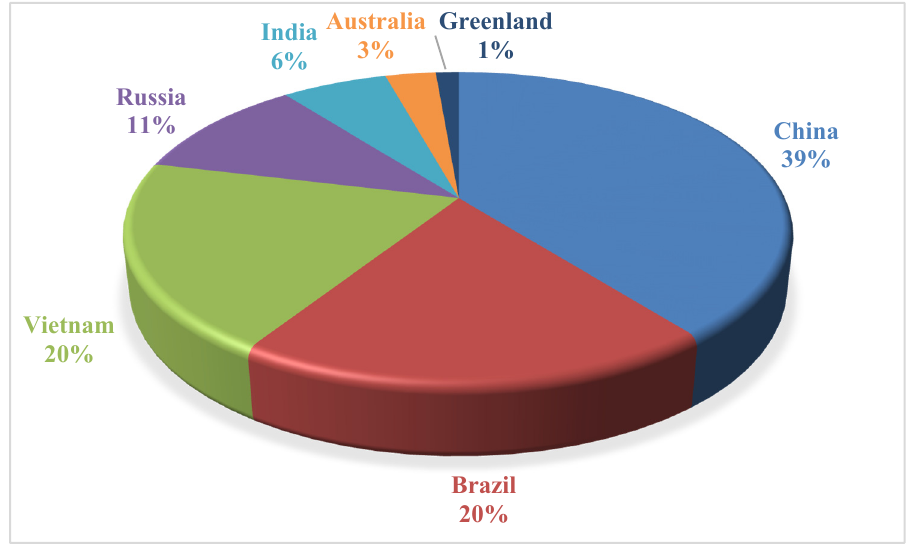
Figure 1. Rare earth oxides (REO) reserves worldwide; estimated statistical data for 2019 [15]. Compared to the global terrestrial (land-based) reserves, REO including Y and Sc can be in significantly higher amounts in the deep oceans, which is particularly known in the Indian and Pacific ocean bottom [2,16]. Notably, it is acknowledged that the two main terrestrial deposits have less than 1% of HREE, whereas in the Pacific cobalt-rich ferromanganese (Fe-Mn) crusts and polymetallic nodules, the amount of HREE can reach a level of as much as 26% [16]. Mining of the main minerals in Fe-Mn nodules and crusts from the bottom of the oceans can recover a very significant amount of REE as by-products [17]. In India, the principal ore mineral for LREE, monazite [(LREE)PO 4 ], is mined mainly in beach placers (70–75%), and the rest are mined in the inland and offshore areas [2]. Other REE minerals in India include ilmenite, sillimanite, garnet, zircon, and rutile, which are all dominantly containing LREE. In general, monazite and xenotime [Y,HREE(PO 4 )] are two main potential resources for REE (LREE and HREE, respectively) that are present in a wide variety of rock types, but the concentration of extracted REE cannot support economies [18] because REE are typically dispersed; i.e., they are not concentrated in economically exploitable ore deposits. For mineral exploration and mining processes, of special interest is the detection of deposits (such as carbonatites, silico-carbonatites, peralkaline granites, pegmatites) enriched in REE. Although deep-sea mineral deposits, such as polymetallic nodules and cobalt-rich crusts, have been known for almost 50 years, only recent studies have indicated that unconsolidated ocean-floor sediments can also be good candidate resources for REE. So far, only a few investigations have focused on a quantita- tive assessment of the deep-sea floor for critical metal resources [19–27]. The estimations emphasize the importance of marine sediments and other classes of deposit (Fe-Mn crusts